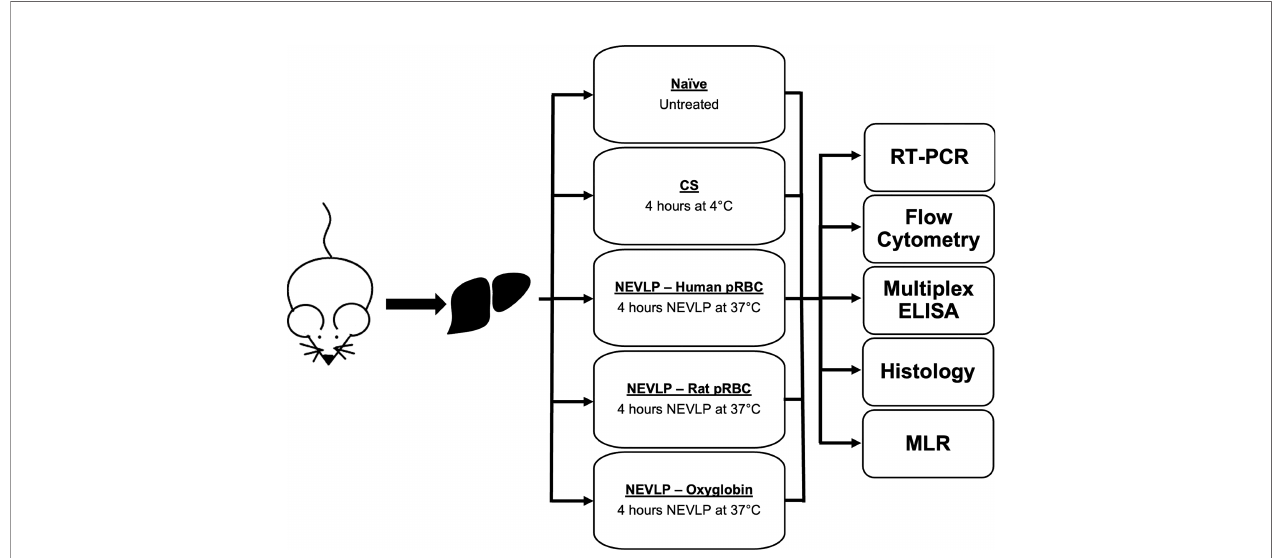
FIGURE 1 | Experimental design. pRBC, packed red blood cells; NEVLP, normothermic ex vivo liver perfusion; CS, Cold